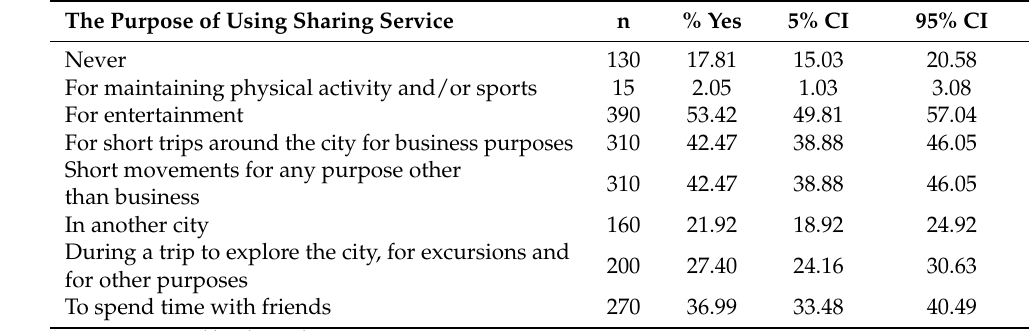
Table A1. Frequency of respondents choosing different goals for using e-scooter sharing service (CI-confidence interval).